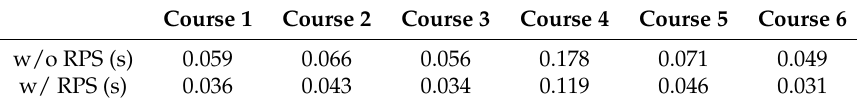
Table 3. The average running time for a one single point according to the